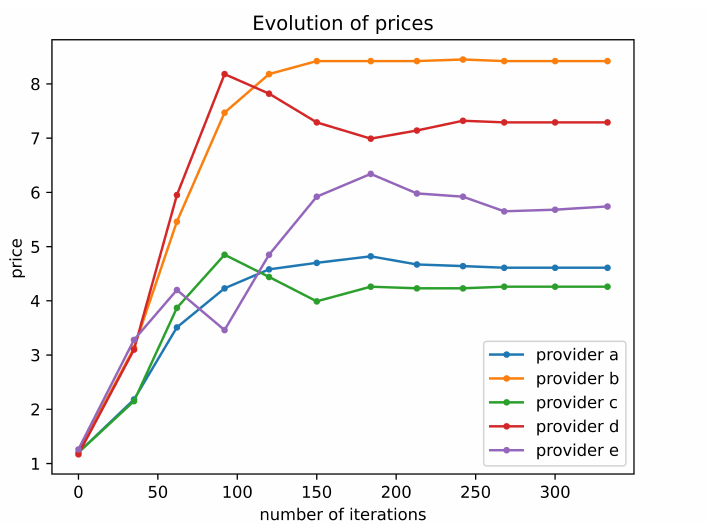
Figure 2. Evolution of difference between demand and supply.